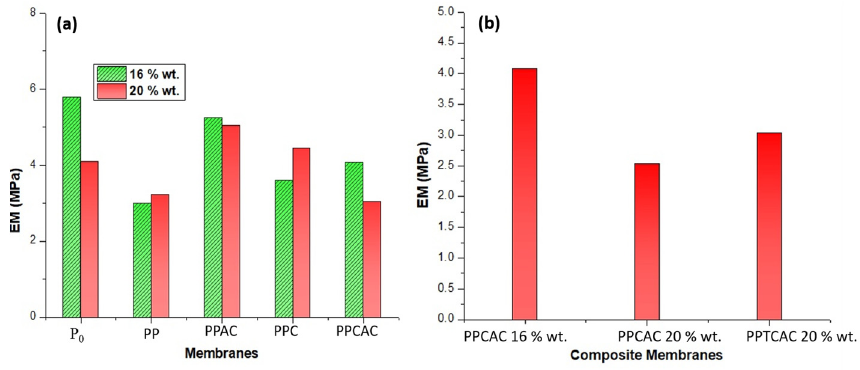
Figure 10. Elastic modulus graph for ( a ) 16 and 20% PES membranes, and ( b ) composite mem-